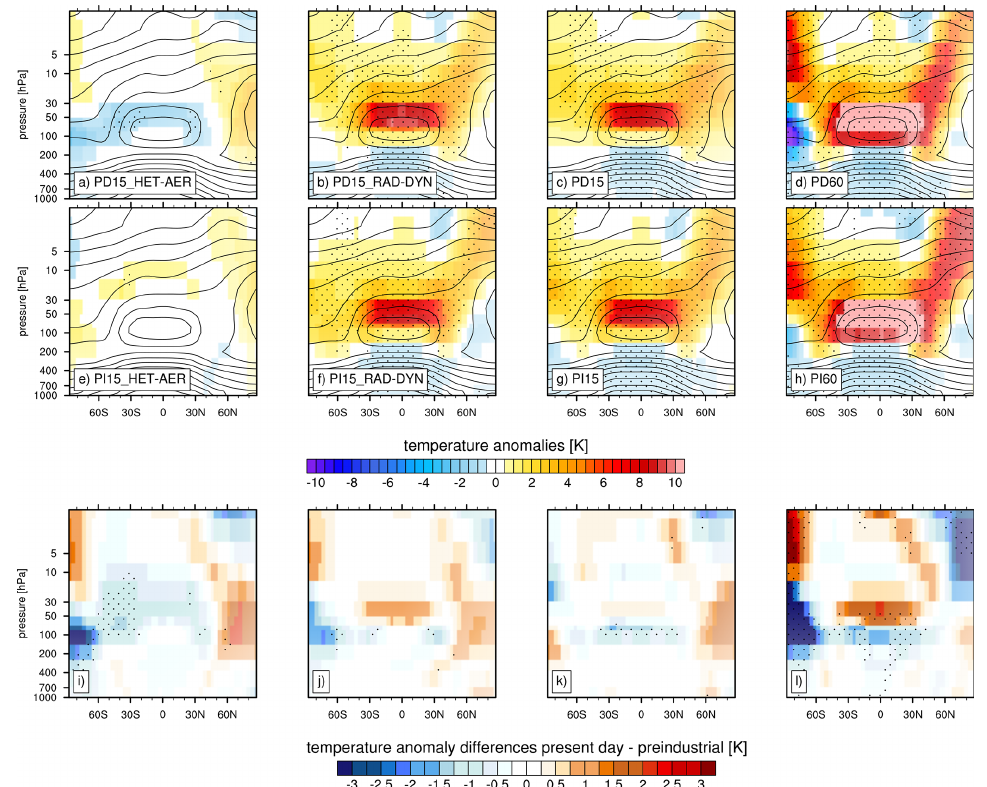
Figure 5. Zonal mean temperature anomalies (K) for the first post eruption winter (DJF) relative to the average of the present-day or preindustrial control simulations: (a) anomalies due to the effect of heterogeneous aerosol chemical reactions (HET-AER) for the 15Tg eruption under present-day conditions, (b) same as (a) , but for the radiative effects of the aerosols, (c) same as (a) , but showing the ensemble mean of the full forcing simulations, (d) full forcing simulations for the 60Tg aerosol forcing data set, and (e–h) similar to (a) , but for preindustrial conditions. Anomalies are calculated relatively to the corresponding control ensemble mean and the stippling in the simulation panels indicates significant differences to the control (Student’s t test p ≤ 0 . 05). Contours denote the climatological mean DJF temperatures in the control ensembles. (i–l) Differences between the present-day and preindustrial temperature anomalies for the different